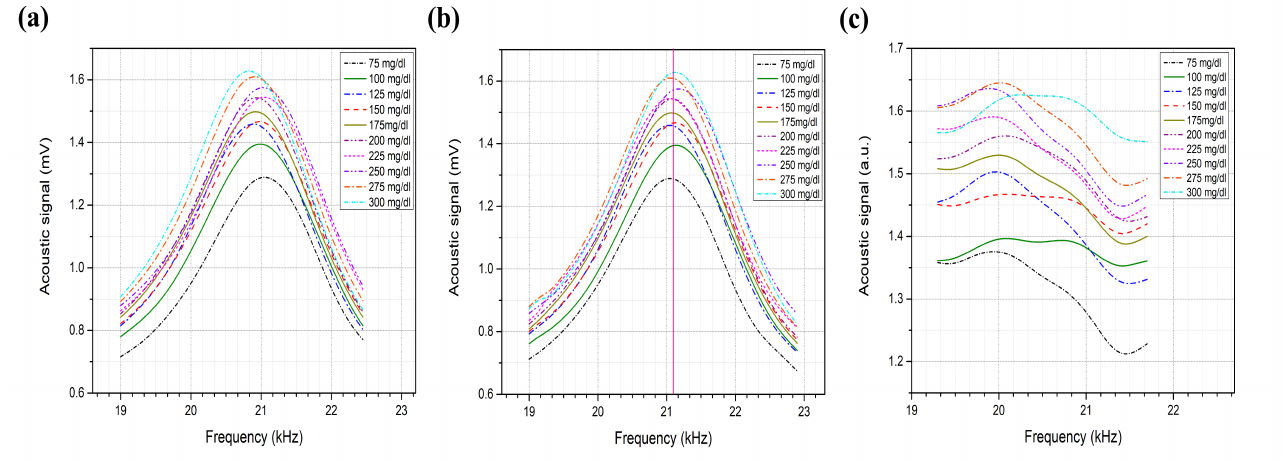
Figure 8. ( a ) Non-rectified acoustic spectrum of the second peak. ( b ) Rectified acoustic spectrum. ( c ) Normalized acoustic spectrum with